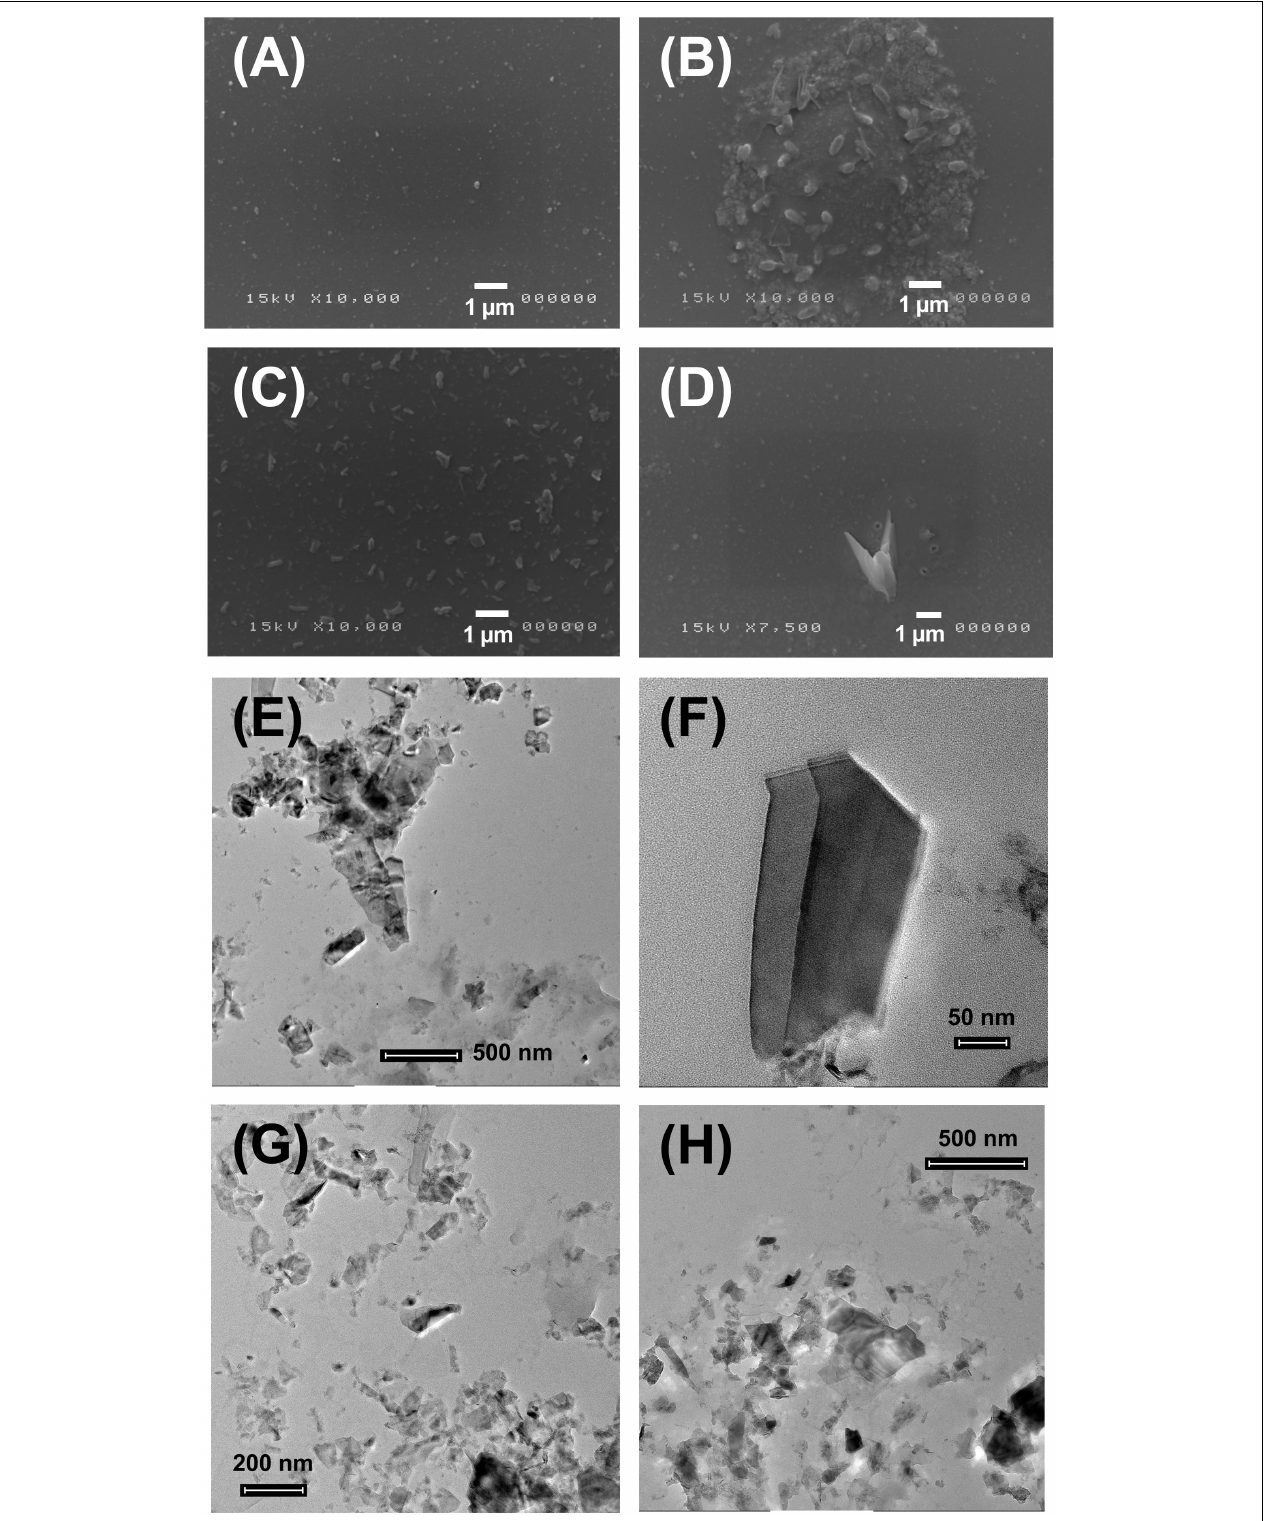
FIGURE 1 | SEM and TEM representation of water dispersed MoS 2 NSs at different resolutions (50 nm – 1 µ m). (A–D) SEM analysis of MoS 2 -H 2 O dispersed NSs centrifuged at 2000 and 3000 g deposited on the gold sputtered silicon substrate. (E–H) TEM analysis of MoS 2 -H 2 O dispersed NSs centrifuged at 2000 and 3000 g deposited on the carbon grid. Scale bar for TEM is in the range of 50 nm – 500 nm and for SEM is 1 µ m.